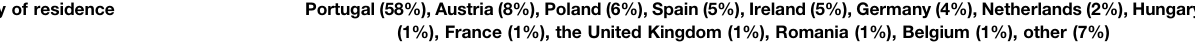
TABLE 2 | Demographic background of spaceEU survey respondents (N (cid:1) 283). Country of residence